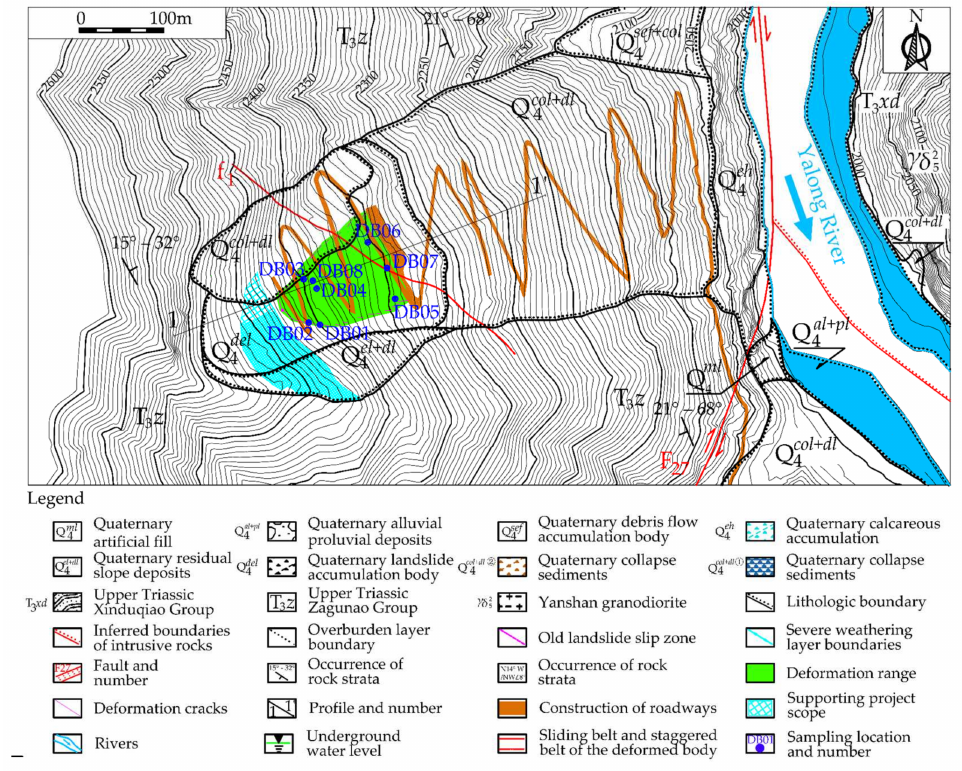
Figure 10. Geological engineering plan of Danbo